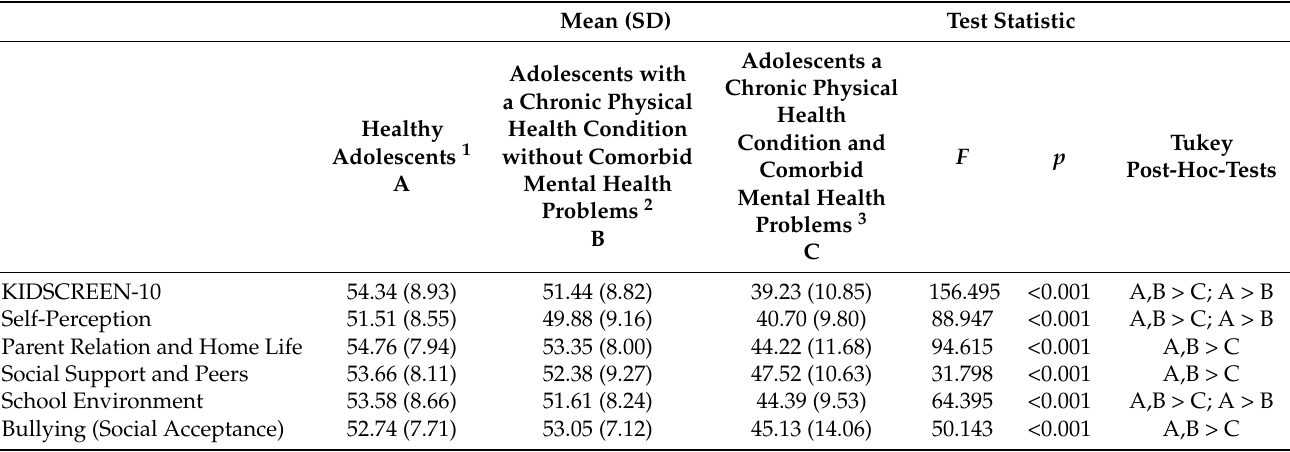
Table 4. Health-related quality of life scores in adolescents with a chronic physical health condition with and without comorbid mental health problems compared to a healthy control